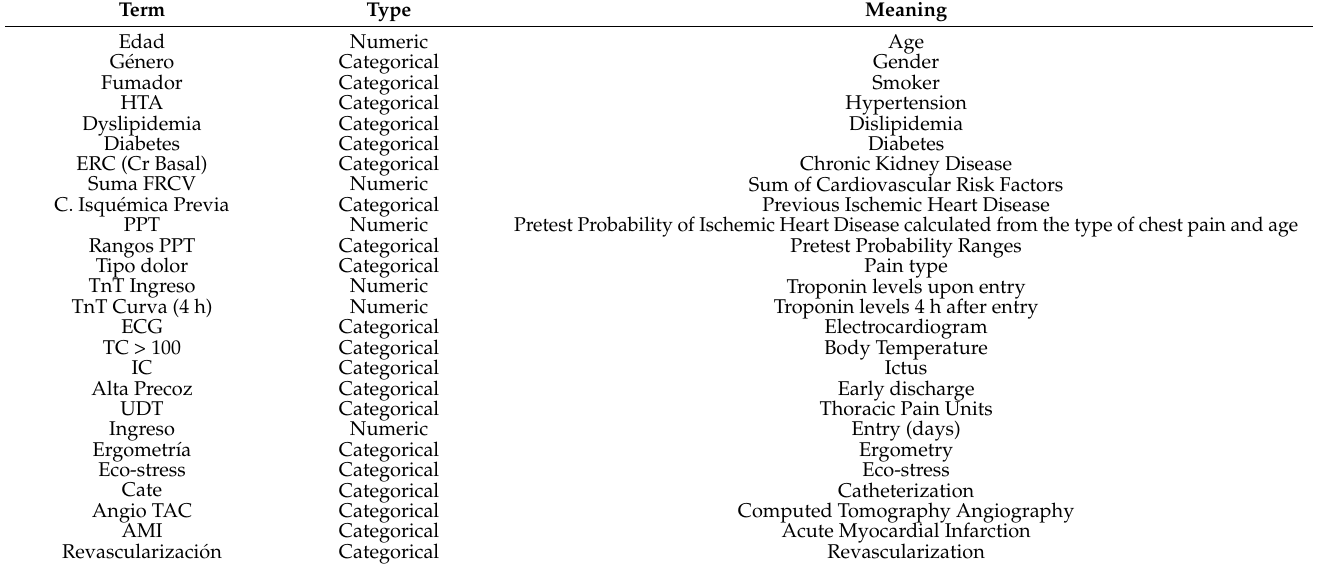
Table A1. Index of terms.